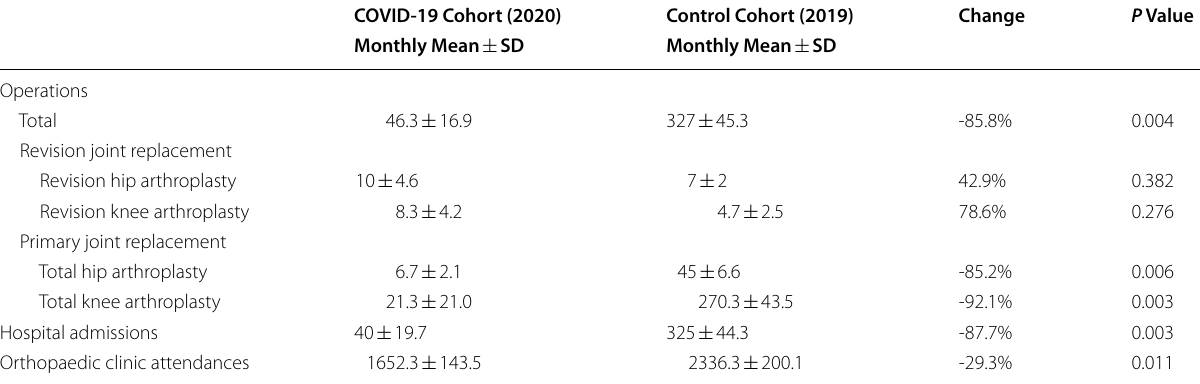
Table 1 Differences in elective arthroplasty services from February to